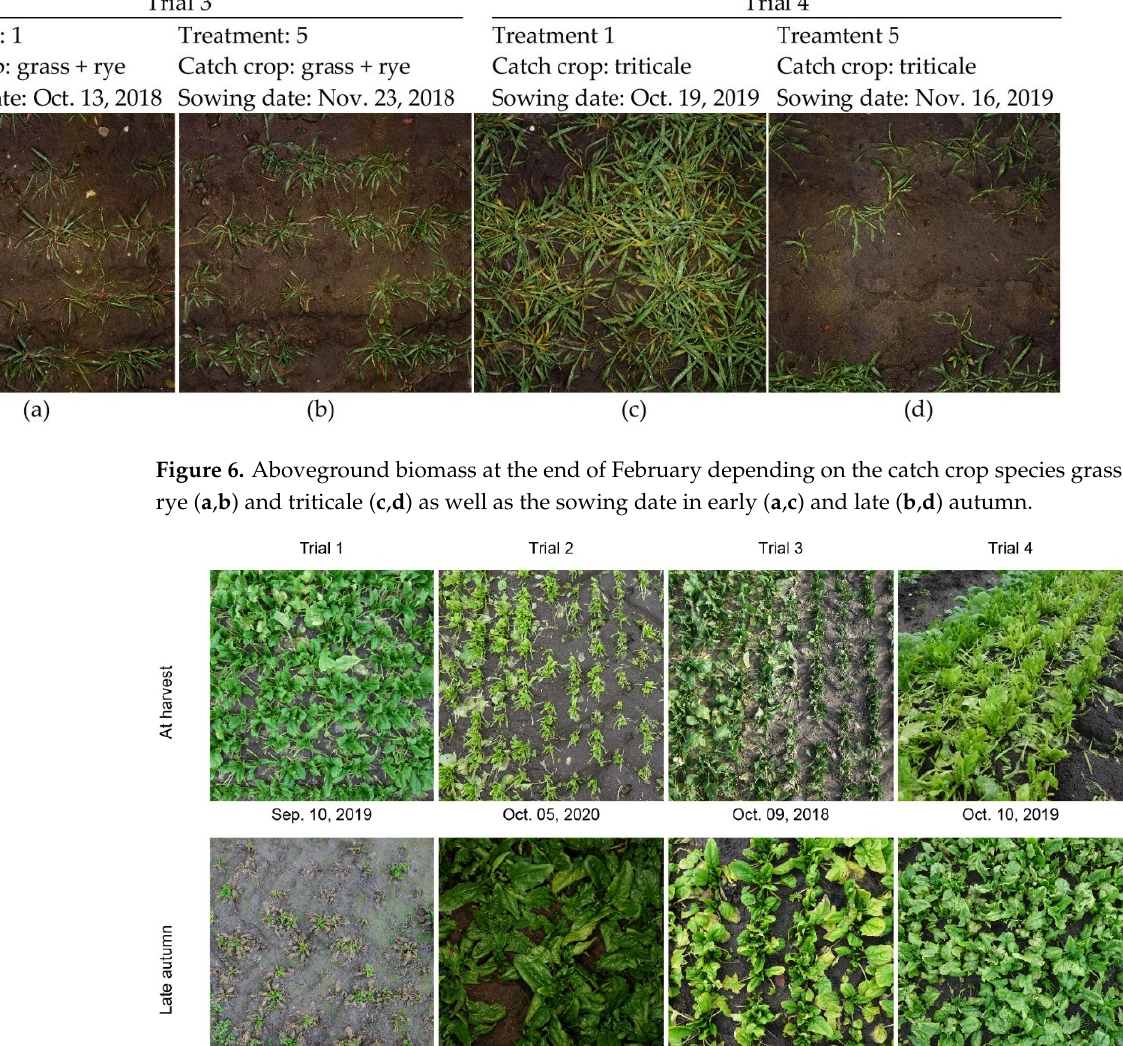
Agronomy 2022 , 12 , x FOR PEER REVIEW 10 of 19